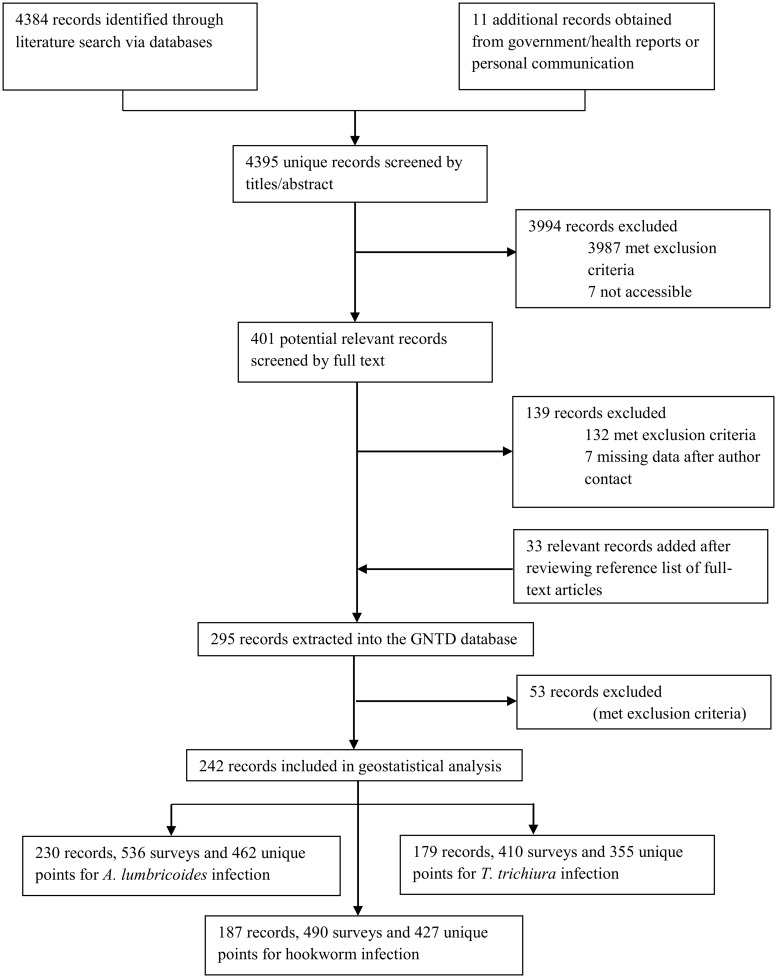
Data selection flow chart.